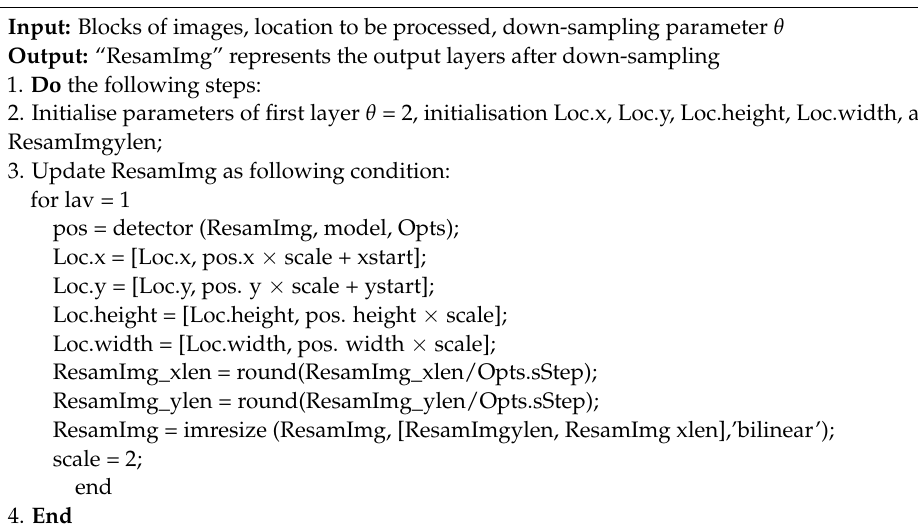
Algorithm 1 Multiscale model